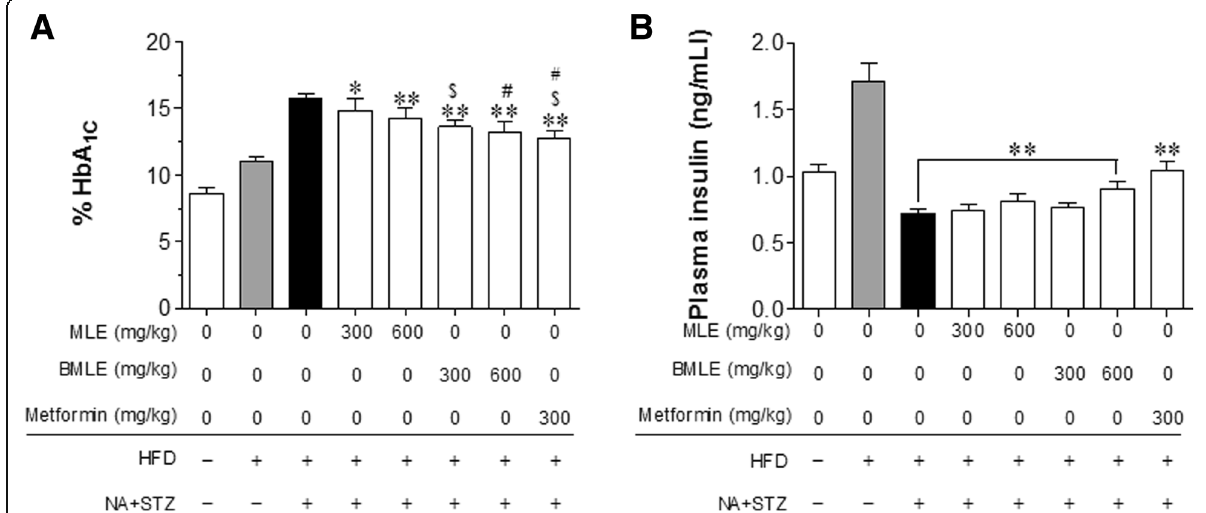
Fig. 6 Effect of bioconverted mulberry leaf extract (BMLE) and unaltered mulberry leaf extract (MLE) on HbA 1C blood concentrations and plasma insulin levels in obese diabetic mice. MLE (300 and 600 mg/kg) or BMLE (300 and 600 mg/kg) were administered (PO) for 7 weeks in obese diabetic mice, and ( a ) the amount of glycated hemoglobin (HbA 1C ) in blood and ( b ) plasma insulin level was measured. Data are expressed as the mean ± SEM ( n = 7). * P < 0.05 and ** P < 0.01 versus the vehicle; $ P < 0.05 versus the MLE-treated group (300 mg/kg); # P < 0.05 versus the MLE-treated group (600 mg/kg). HFD, high-fat diet; NA, nicotinamide; STZ,